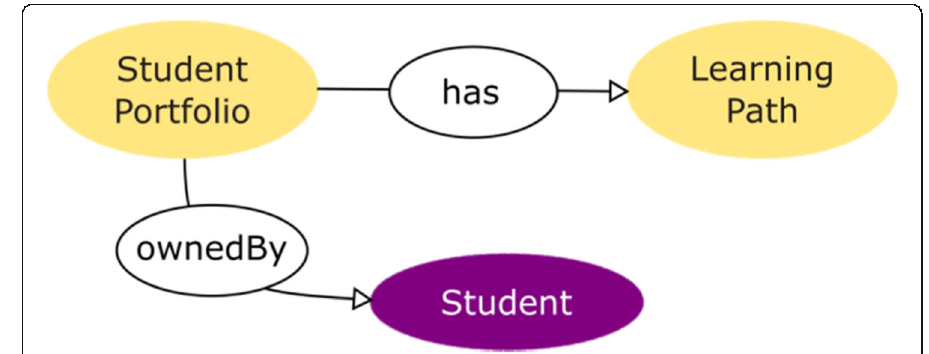
Fig. 5 Relation between Student Portfolio and Learning Path